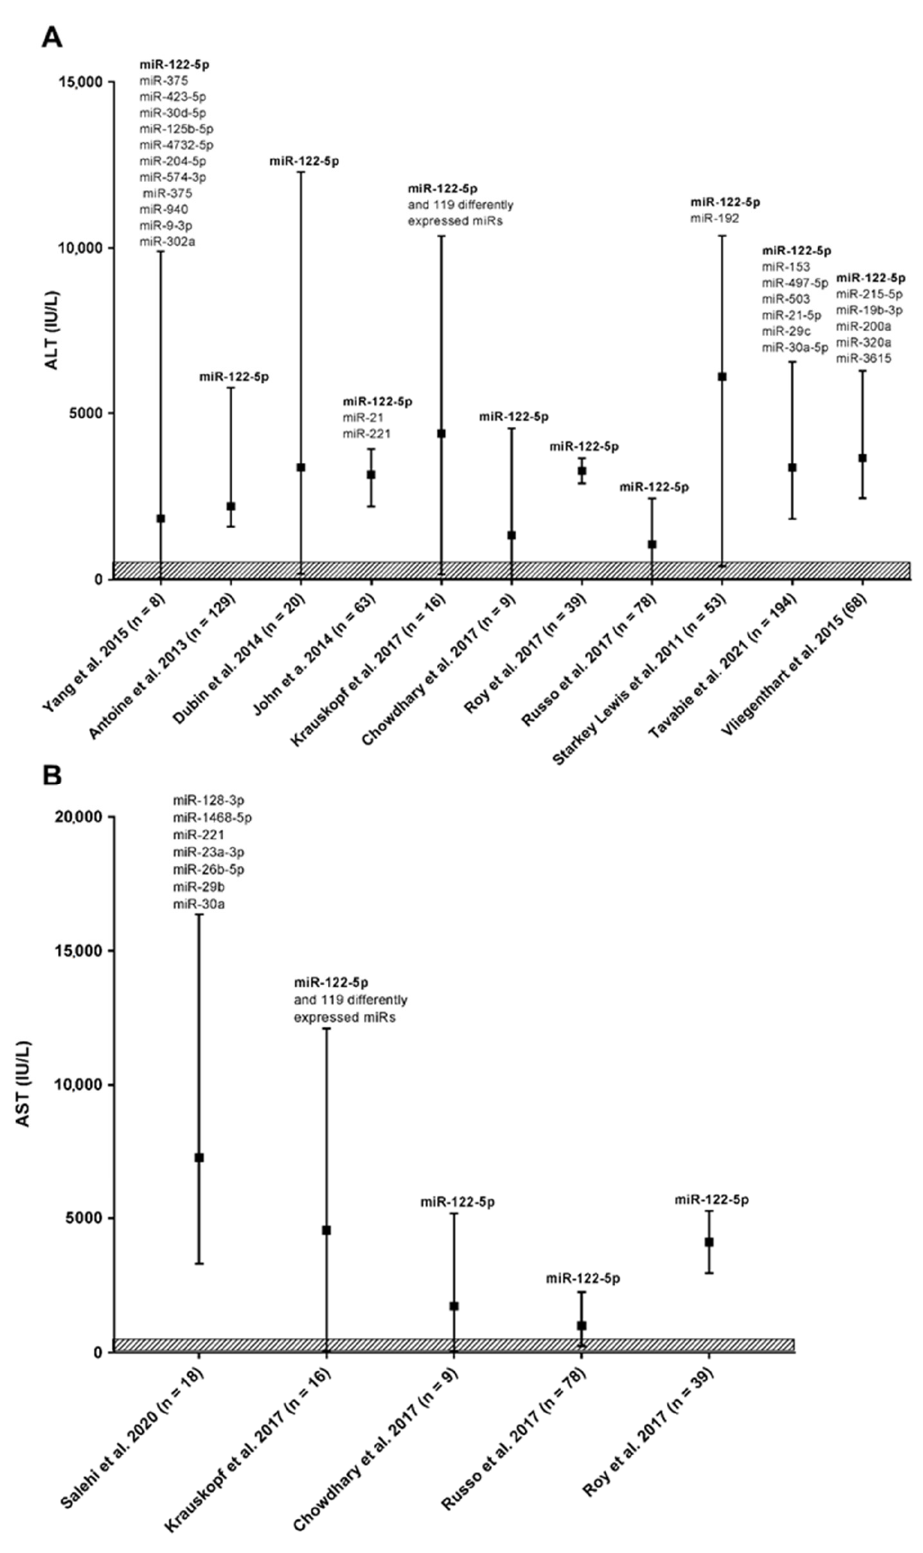
Figure 3. ALT (panel ( A )) and AST (panel ( B )) activity in serum of ALF patients with upregulated miRNAs. Black squares represent medians, bars range of measured ALT activity. Above the bars are listed differently expressed miRNAs reported in each cohort. The norm value for ALT/AST activity in blood for people without risk factors for liver disease in international units per liter (IU/L), according to the American College of Gastroenterology, is indicated as a patterned box.